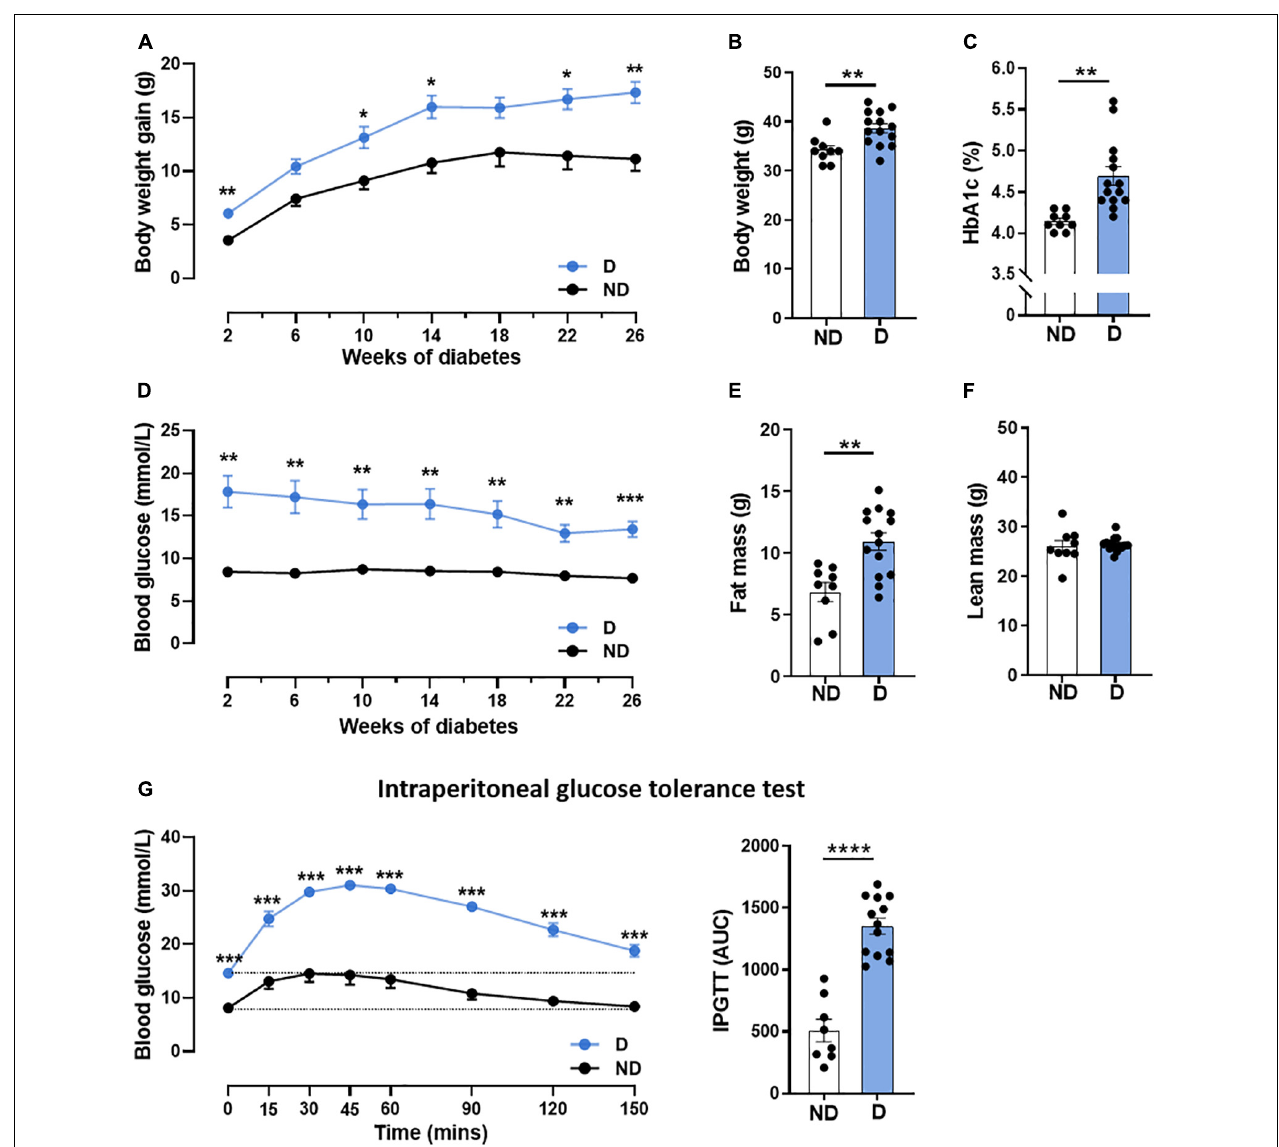
FIGURE 1 | Characterisation of systemic phenotype in diabetic mice. (A) Body weight gain over time, (B) end-point body weight, (C) glycated haemoglobin (HbA1c), (D) blood glucose over time, (E) fat mass, (F) lean mass, (G) intraperitoneal glucose tolerance test (IPGTT); dotted line indicates basal glucose for each group where AUC is calculated. Data represented as mean ± SEM. n = 8–14 per group (note individual data points). Data analysis used unpaired t -test. * P < 0.05, ** P < 0.01, *** P < 0.001, **** P < 0.0001. ND, non-diabetic; D, diabetes; AUC, area under